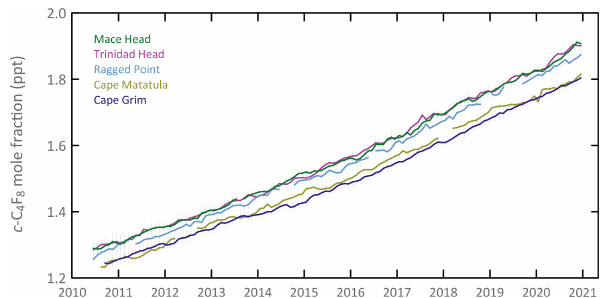
Figure 1. Pollution-free monthly mean mole fraction calculated from in situ c -C 4 F 8 measurements at five AGAGE sites using the AGAGE statistical method (Cunnold et al., 2002) (https://agage.mit. edu/data/agage-data, last access: 18 August